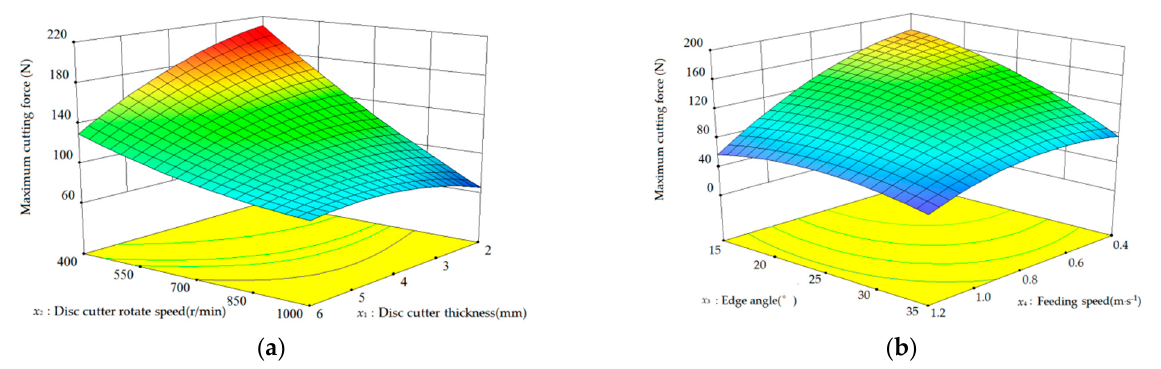
Figure 7. Response surface of the maximum cutting force. ( a ) Interaction factors of disc cutter rota- tion speed and thickness ; and ( b ) interaction factors of edge angle and feeding speed. speed and thickness; And ( b ) interaction factors of edge angle and feeding